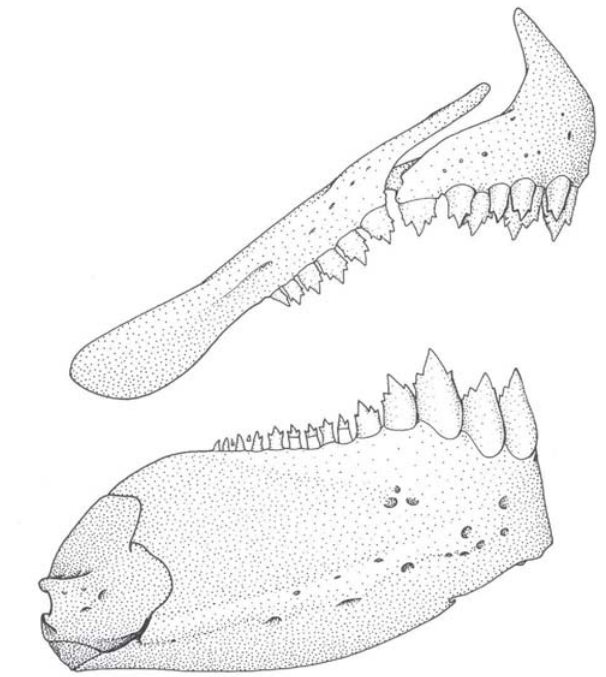
Fig. 18. Glandulocauda melanopleura , adult male, USNM 236415, 42.6 mm SL; jaws and dentition, lateral view, right side, anterior at